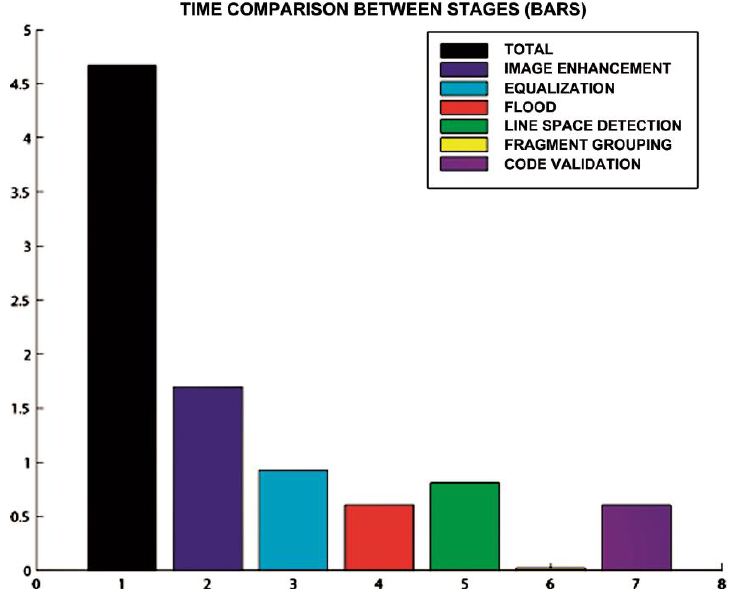
Figure 17. Total time (measured in seconds on the ordinate axis) taken by the algorithms during a recording of 44.42 s. The algorithm described in this paper corresponds to bar 7. recording of 44.42 s. The algorithm described in this paper corresponds to bar